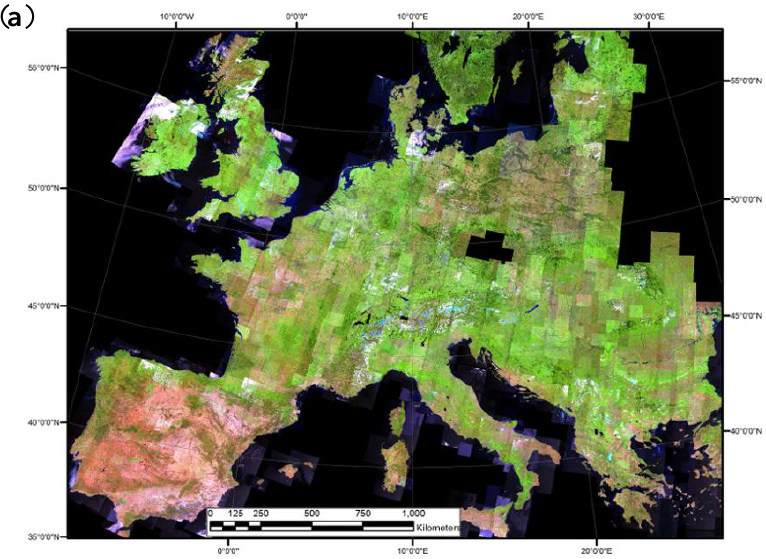
Figure 8. Previously shown in [23]. ( a ) 4-band GMES-IMAGE 2006 Coverage 1 mosaic, consisting of approximately two thousand 4-band IRS-P6 LISS-III, SPOT-4, and SPOT-5 images, mostly acquired during the year 2006, depicted in false colors: Red: Band 4 (Short Wave InfraRed, SWIR), Green: Band 3 (Near IR, NIR), Blue: Band 1 (Visible Green). Down-scaled spatial resolution: 25 m. ( b ) Preliminary classification map automatically generated by S-SIAM™ from the mosaic shown in (a). To the best of these authors’ knowledge, this is the first example of such a high-level product automatically generated at the European Commission-Joint Research Center (EC-JRC). Output spectral categories are depicted in pseudo colors. Map legend: similar to Table